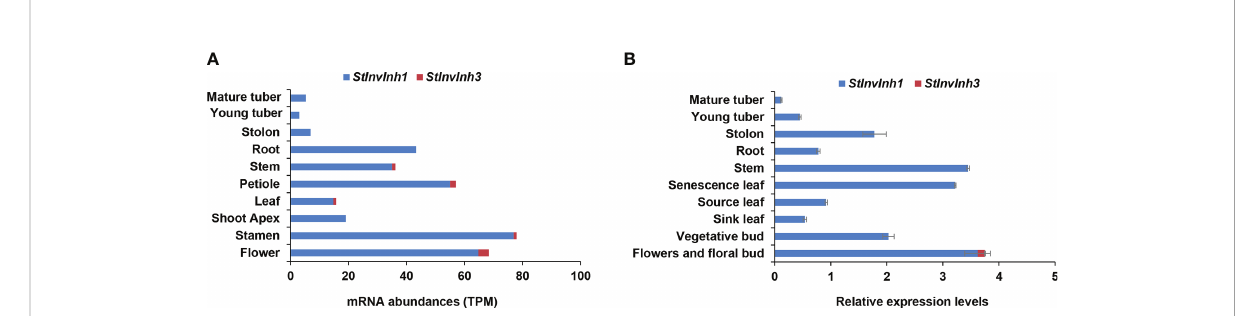
FIGURE 1 Relative expression levels of putative cell wall invertase inhibitor genes in various organs of potato plants. (A) The mRNA abundances of StInvInh1 and StInvInh3 are estimated from RNA-seq data of potato genotype RH in silico . (B) The relative expression levels of StInvInh1 and StInvInh3 genes are presented in relation to the expression levels of ef1 a (AB061263) transcripts (100) by RT-qPCR. Data are means ± SD of three independent